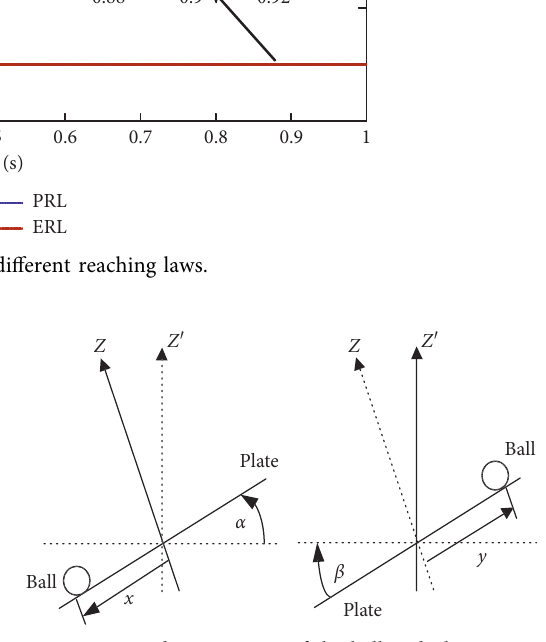
Figure 2: Coordinate system of the ball and plate